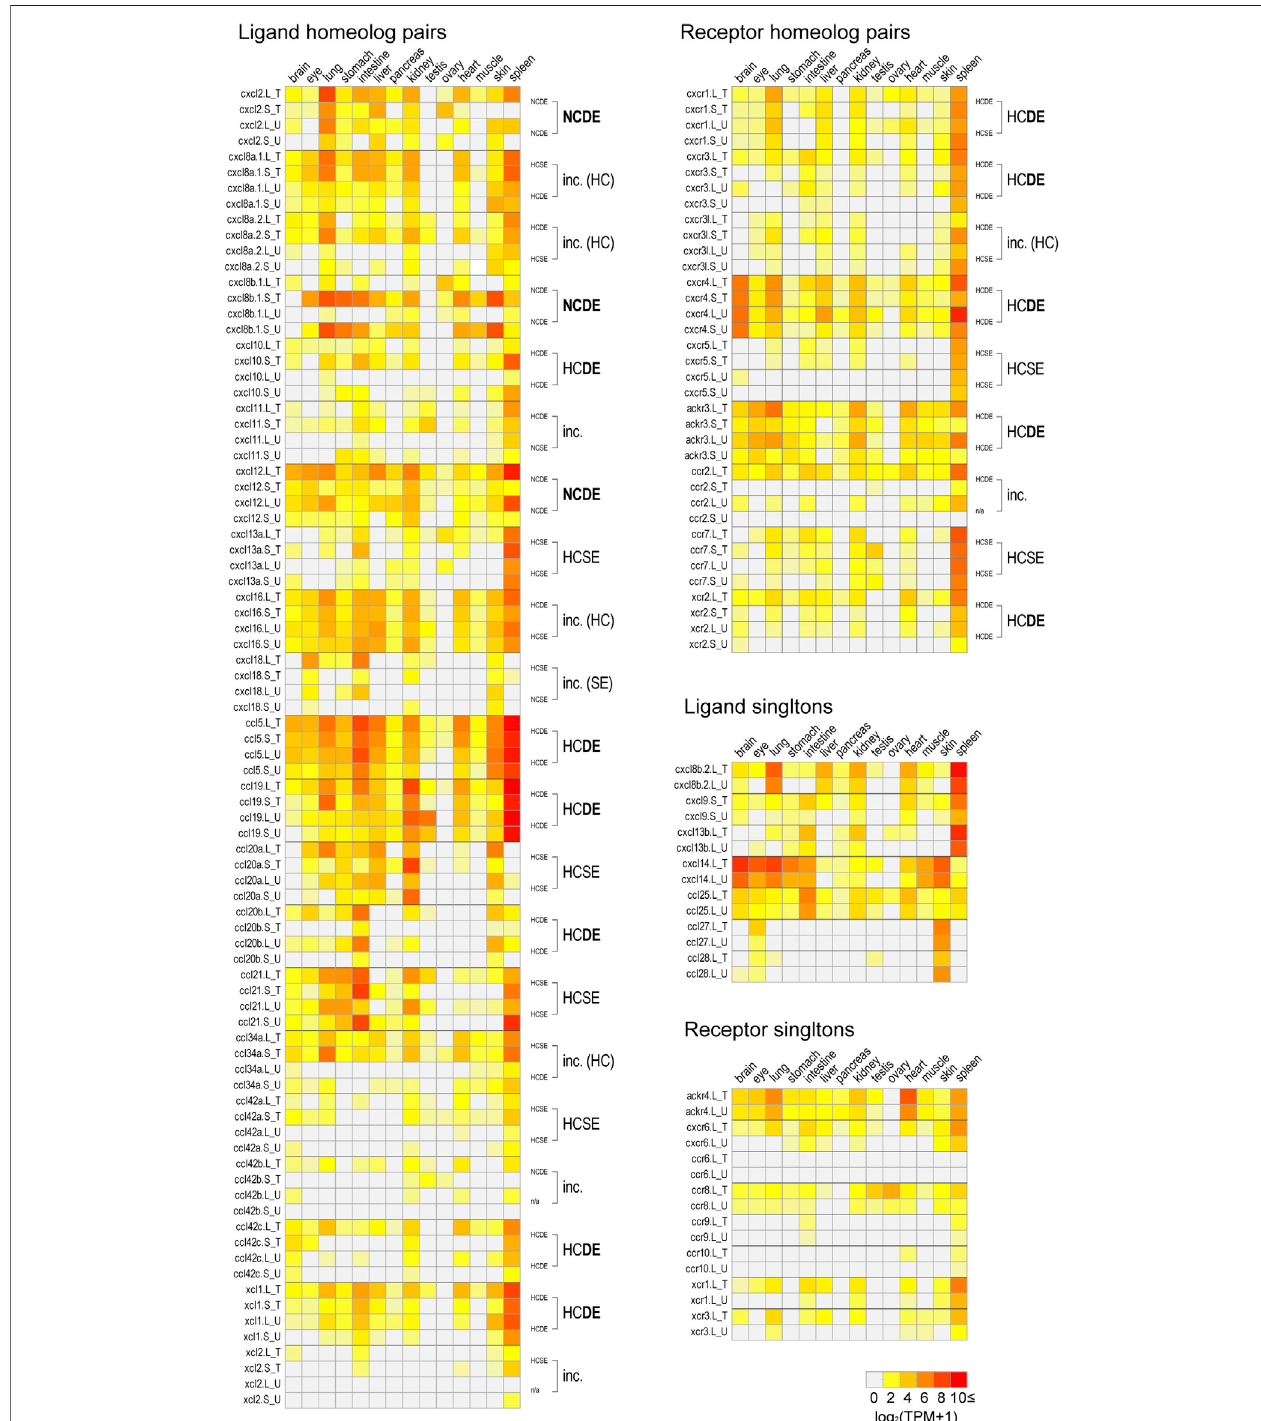
FIGURE6| Expressionpro fi lesinadulttissues.log2transformedTPMvaluesinClutchTandClutchU[log2(TPM+1)]ofallchemokineligandandreceptorgenesof brain, eye, lung, stomach, intestine, liver, pancreas, kidney, testis, ovary, heart, muscle, skin, and spleen are presented with heat maps. For each homeologous pair, transcriptome correlation groups are indicated on the right side of panels. In cases of the “ inc. ” group, their details are described with parentheses. If results from two clutches showed half-consistency,theircommon resultsareindicated(HC orSE). Singletons were presented in theseparated panels. All TPMvalues areshown in Supplementary Table S1